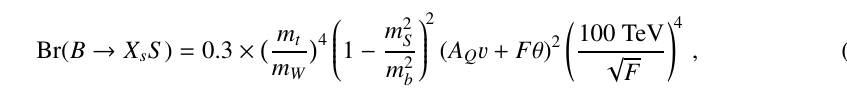
matically allowed), while γγ and μ + μ − give small but noticeable